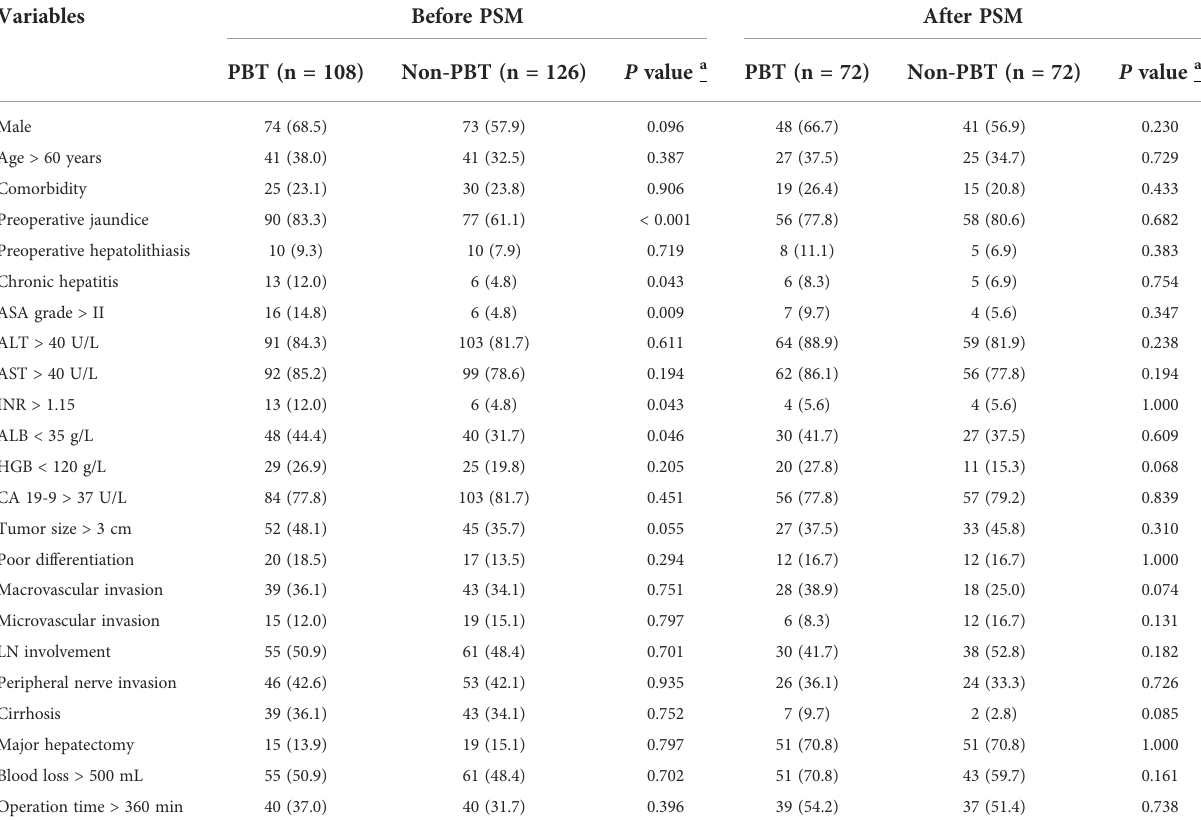
TABLE 5 Clinicopathologic characteristics of the PBT and non-PBT groups among patients with non-early stage (8th AJCC stage II-IV) pCCA treated with curative resection.